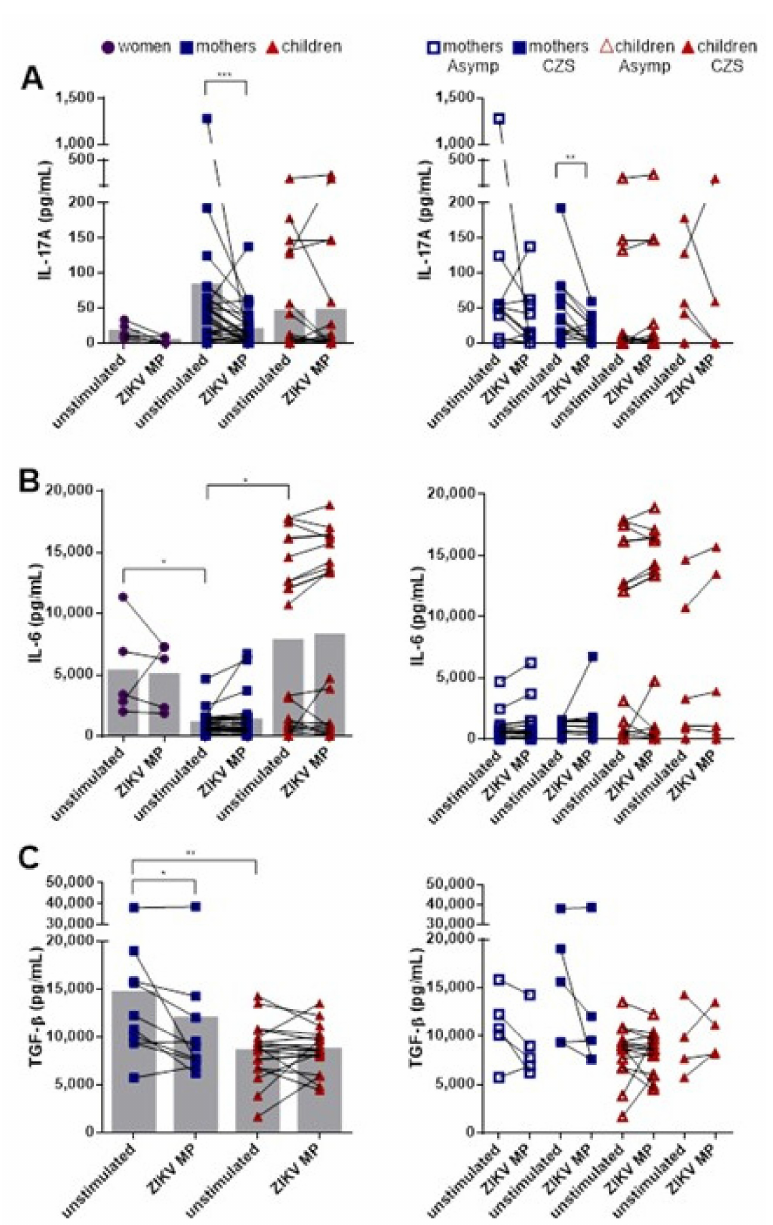
Figure 5. Levels of IL-17A, IL-6 and TGF- β after stimulation with ZIKV MP in individuals with a history of ZIKV infection. Cytokine production in culture supernatants without stimulation or after 20 h of stimulation with ZIKV MP were quantified by means of ELISA. The data represent women (from non-pregnant women infected with ZIKV, violet circles, n = 5), mothers (from pregnant mothers infected with ZIKV, blue squares, n = 19) and children (from children born to mothers infected with ZIKV during pregnancy, red triangles, n = 17) with histories of ZIKV infection. ( A ) IL-17 levels among the groups: between mothers who had asymptomatic babies ( n = 9) and those who had babies with CZS ( n = 10), and between asymptomatic children ( n = 11) and those born with CZS ( n = 6). Similarly, for ( B ) IL-6 and ( C ) TGF- β . Differences between cells stimulated with ZIKV MP and unstimulated cells were analyzed using the Wilcoxon matched-pairs signed rank test. Each data point represents a single individual determination without (unstimulated) and after stimulation with ZIKV MP. Grey bars represent the mean for each group. Asterisks indicate significant differences (* p < 0.05, ** p < 0.01, *** p <